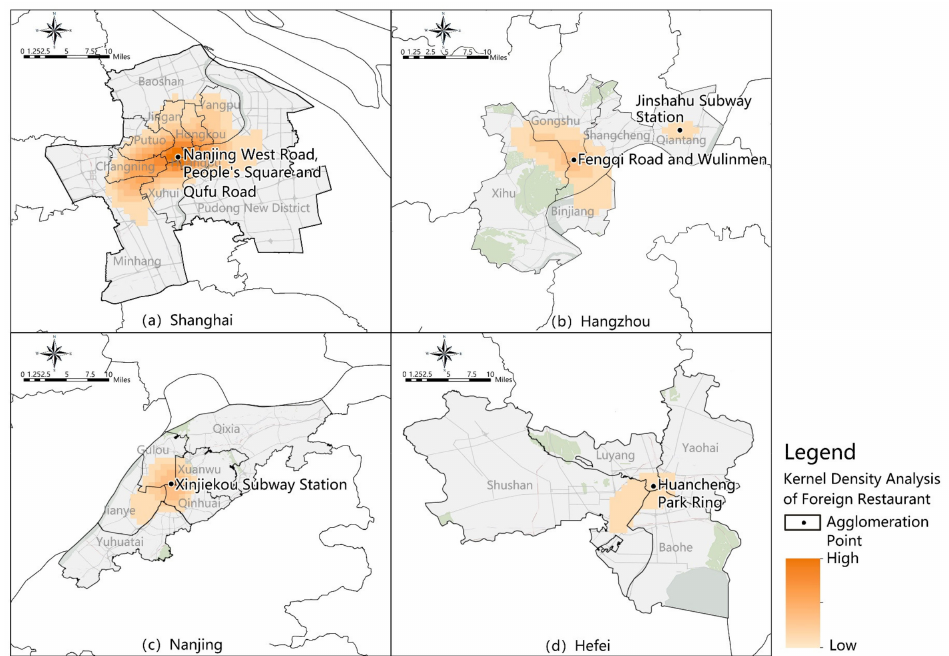
Figure 3. Kernel density analysis of foreign restaurants in the main urban areas of the four central cities in the